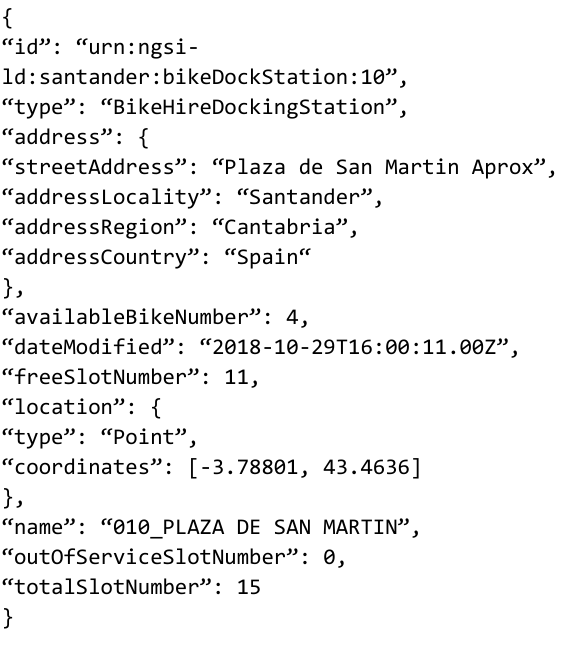
Figure 11. Data models transformation example.